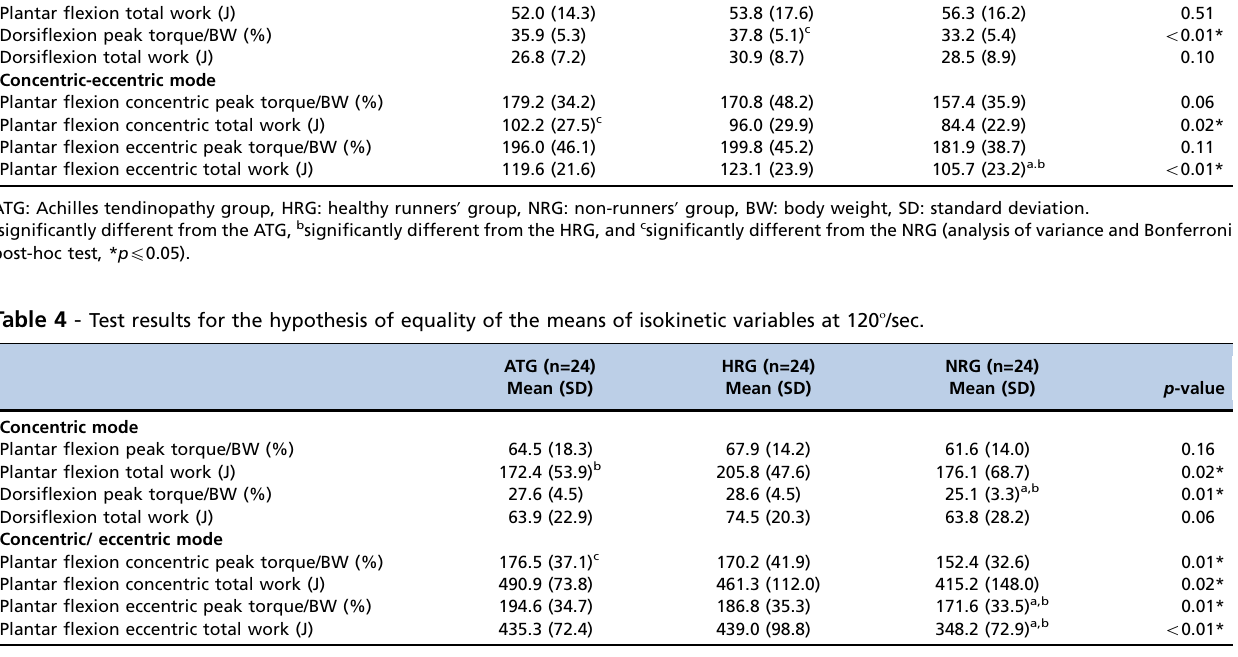
ATG: Achilles tendinopathy group, HRG: healthy runners ’ group, NRG: non-runners ’ group, BW: body weight, SD: standard deviation. a significantly different from the ATG, b significantly different from the HRG, and c significantly different from the NRG (analysis of variance and Bonferroni post-hoc test, * p p